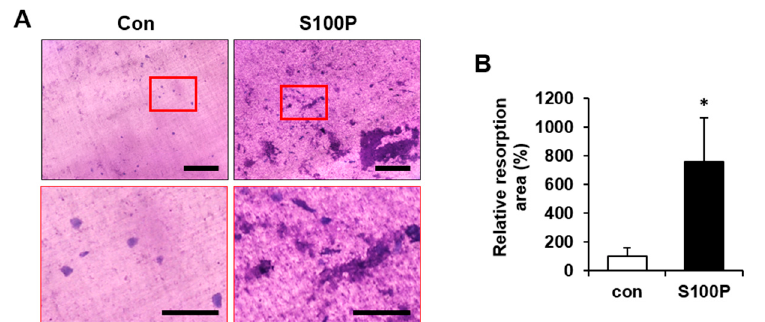
Figure 4. Effect of recombinant human S100P protein on bone resorptive activity. ( A ) Bone marrow-derived macrophages (BMMs) were cultured in osteoclast differentiation medium containing M-CSF (20 ng/mL) and RANKL (20 ng/mL) in the presence of 5 nM S100P. After 5 days of differentiation, dentin slices were stained with toluidine blue solution to observe the resorption pit, and representa- tive images are shown. Scale bar, 500 µ m. High-magnification images of the red rectangles in the upper panels are shown in the lower panels. Scale bar, 200 µ m. ( B ) Quantification of the percentage of bone resorption area per total dentin slice using the i-Solution image analysis program. The resorption pit area is relative to that of the dentin slices of cultured BMMs without S100P, which was set to 100%. *, p <